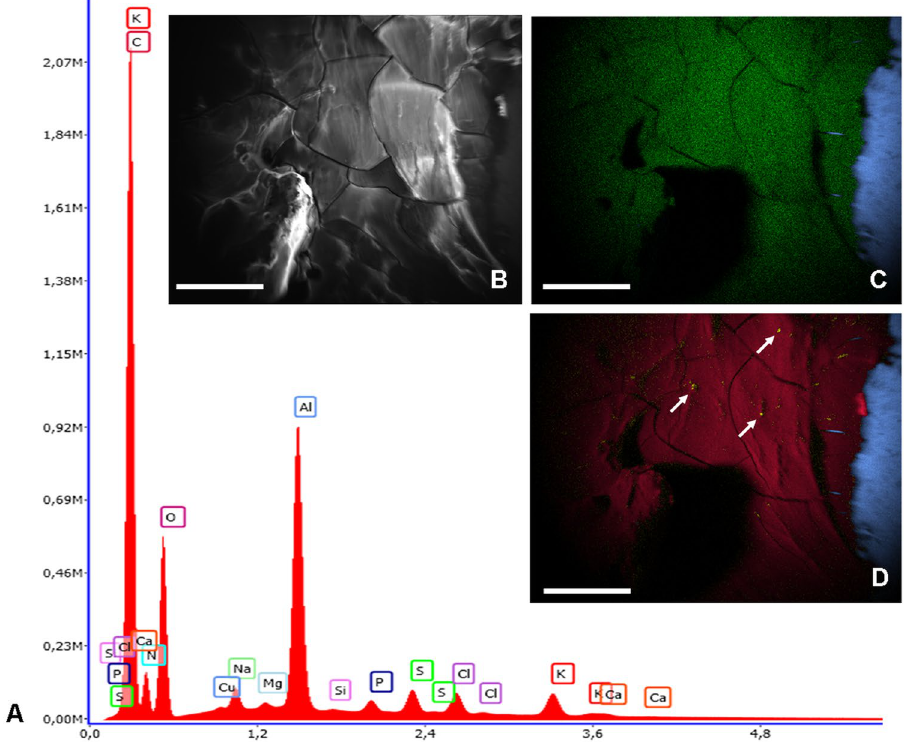
Figure 2. ( A ) Spectrum of the elemental composition of the salamander secretion. Insert ( B ) SEM and corresponding dot mappings for the elements ( C ) sulphur (green) and aluminium (blue) resp. ( D ) carbon (red), aluminium (blue) and calcium (yellow spots and white